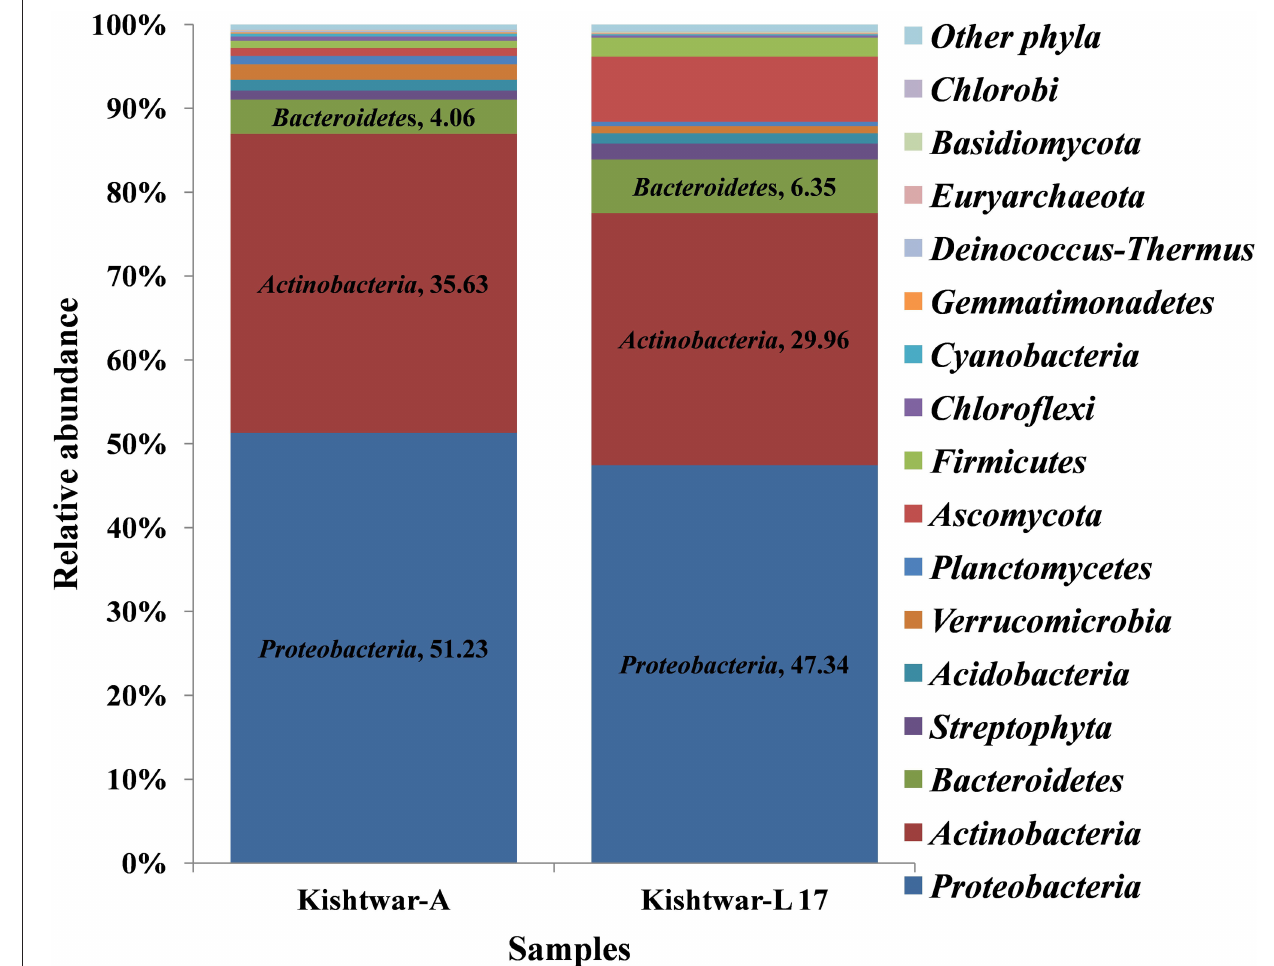
FIGURE 4 | Abundance of different phyla in Kishtwar-A and Kishtwar-L 17. The bar graph depicts 15 phyla (12 bacterial, 2 fungal, 1 archaeal) cataloged from the cormosphere of saffron grown in Kishtwar fields and one laboratory grown sample.